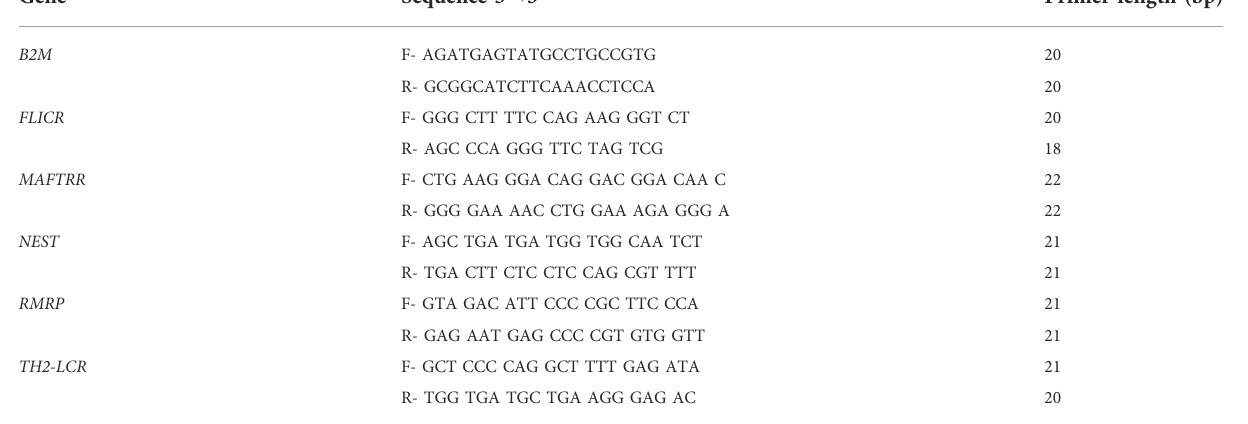
TABLE 2 Primer sequences.